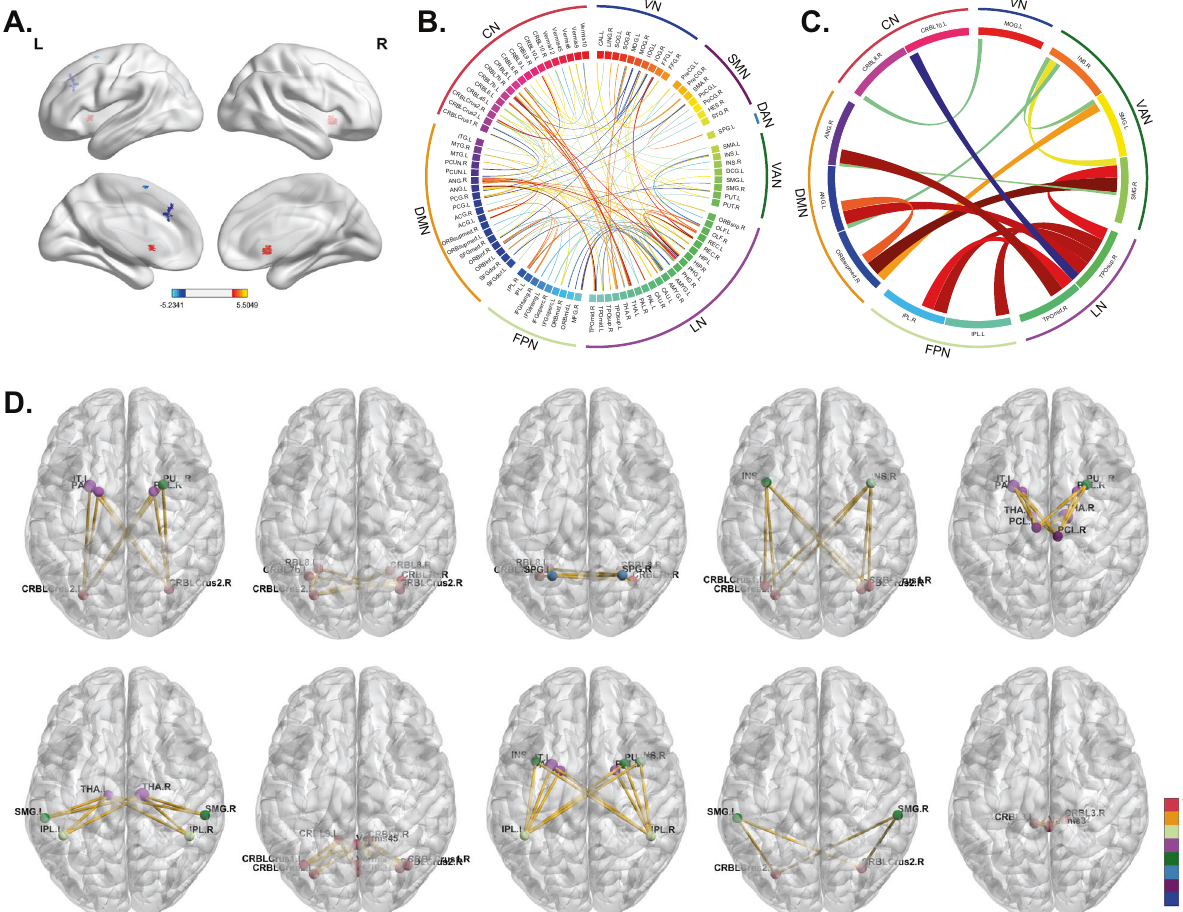
Fig. 5 The identi fi ed biomarkers with signi fi cantly discriminative power. A The cluster map shows the results of the two-sample t-test with GRF correction on ALFF. The clusters with the peak activation strength (t-value) signed ‘ + ’ are colored in orange, and those signed ‘ - ’ are colored in blue; B , C The circos maps shows the abnormal brain region connectivity of SLR ( B ) and SSGSR ( C ). The ROIs of the AAL atlas are denoted on the inner circle, the corresponding brain networks [16] on the outer one. The width and color of links encode the t-value. The wider links correspond to the larger absolute t-values; the warm colors (red and orange) and cool colors (blue and cyan) correspond to the positive and negative t-value, respectively. D The selected top 10 dHOFC clusters of functional connectivity were drawn within the brain surface. The node color represents the functional network to which it belongs. VN visual network; SMN sensory-motor network; DAN dorsal attention network; VAN ventral attention network; LN limbic network; FPN frontoparietal network; DMN default mode network; CN cerebellum network.